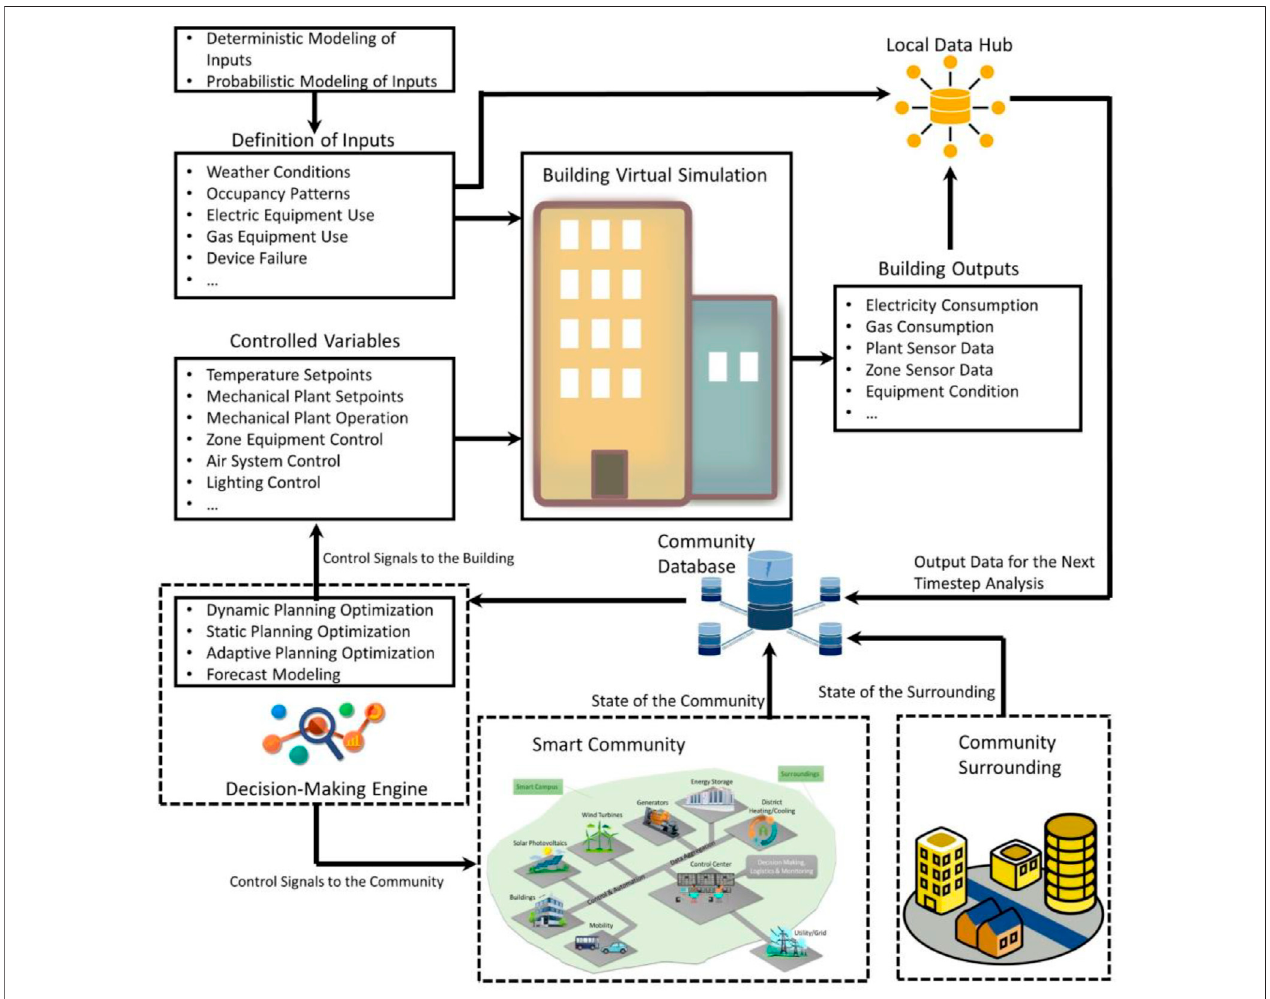
FIGURE 6 | Example of input/output streams of data for a building as a component of a connected ecosystem.